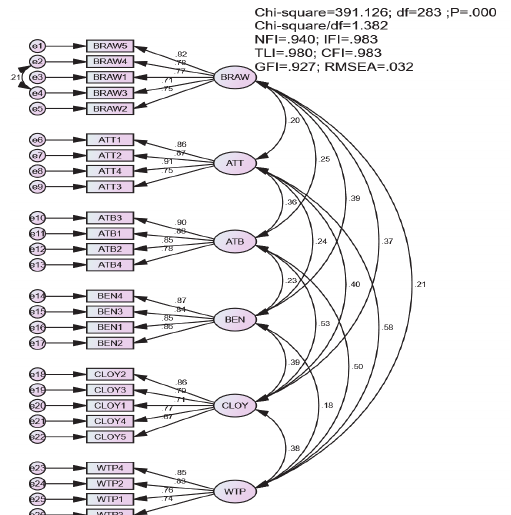
Fig. 2. Measurement Model with Standardized Estimates